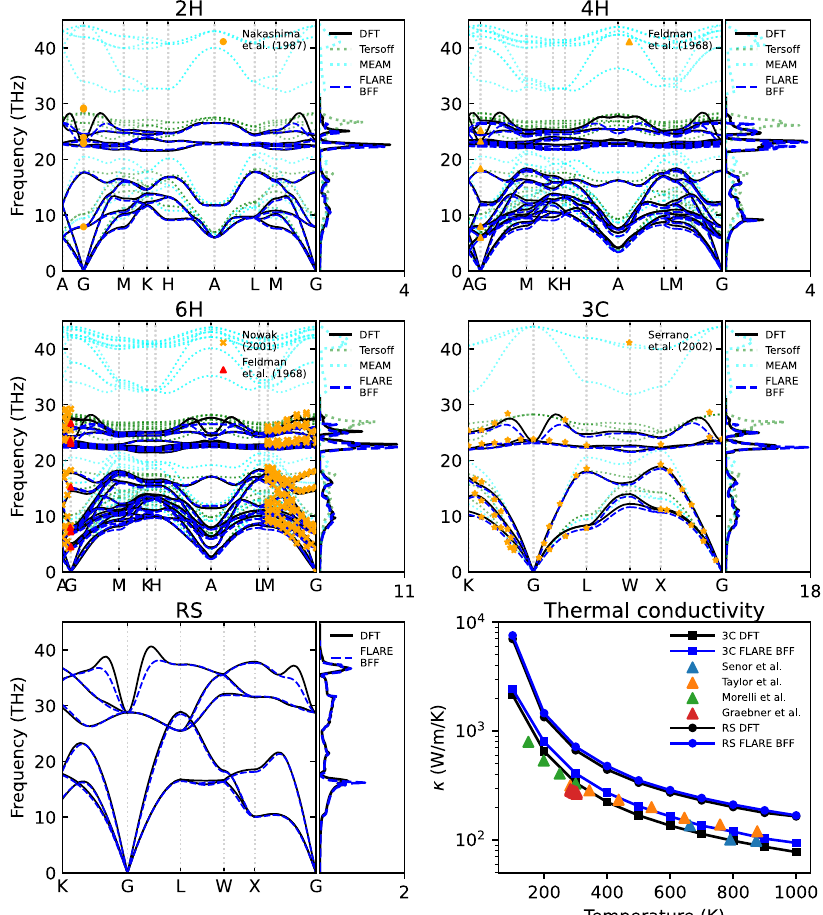
Fig. 5 Phonon dispersions and phonon density of states of different polytypes from experimental measurements 60 – 63 , FLARE BFF and DFT calculations. Lower right: Thermal conductivity of 3C-SiC at 0 GPa and RS phase at 200 GPa with temperatures from 100 to 1000 K, from DFT and FLARE BFF calculations, and the experimental measurements 69 – 72 are for